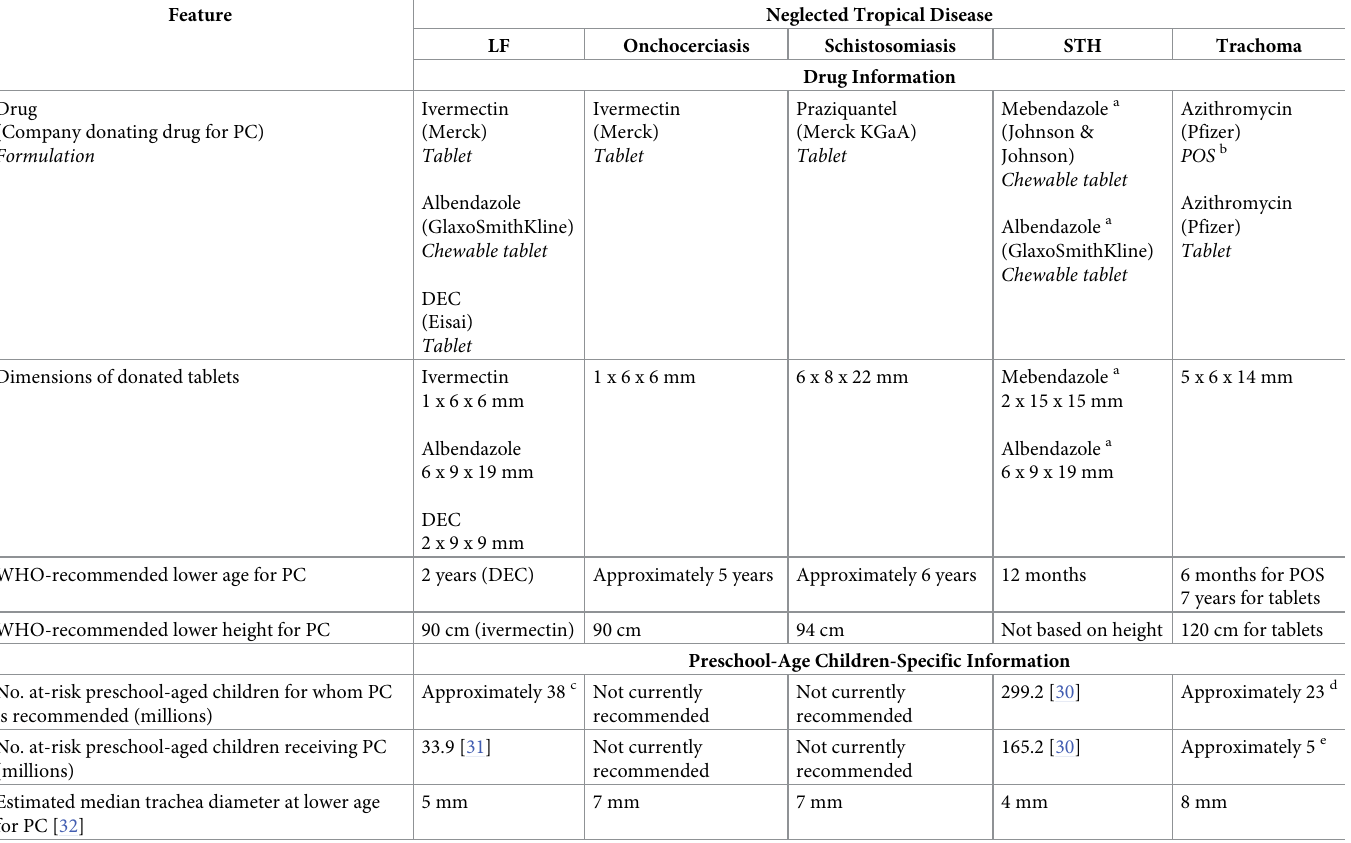
Table 2. Features of drugs used in preventive chemotherapy to control and eliminate neglected tropical